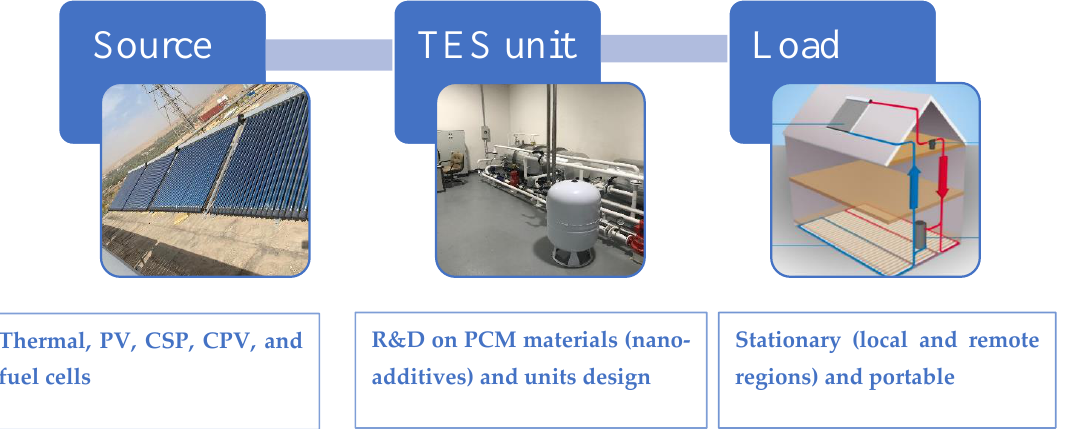
Figure 1. A thermal energy storage system mainly consists of a source of thermal energy (such as solar tubes, as shown) and a TES unit to store the thermal energy for some period of time to be used by a load for domestic or industrial use.